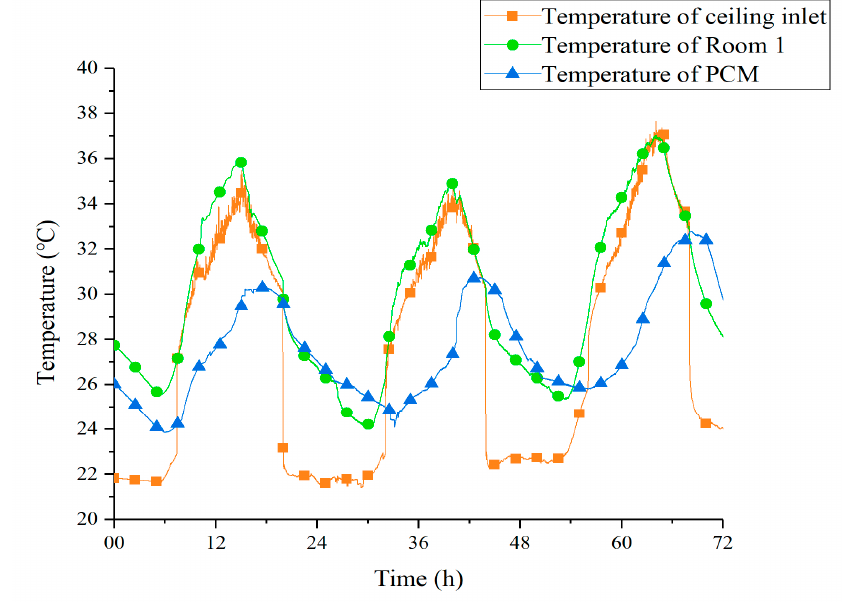
Figure 10. Temperature curves of PCM, tunnel outlet, and Room 1 under Strategy 1.